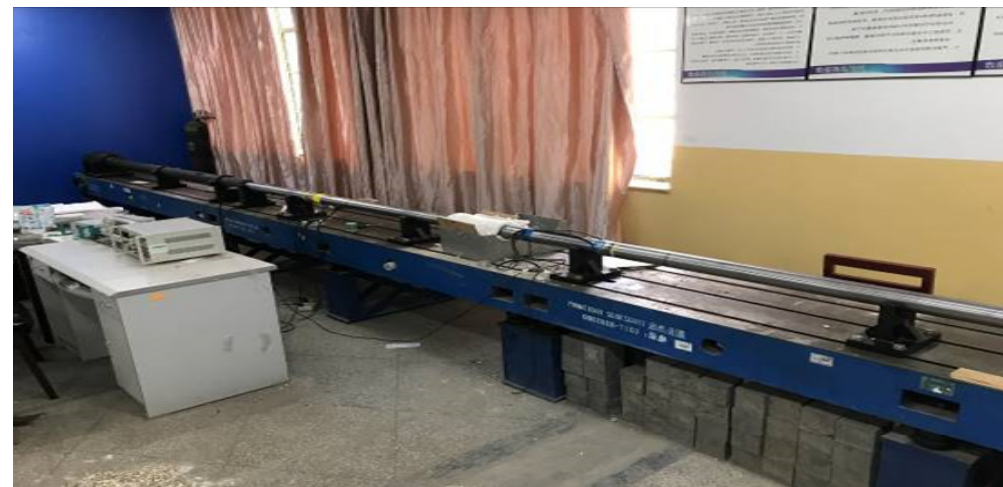
Figure 3. Split Hopkinson pressure bar (SHPB) system.